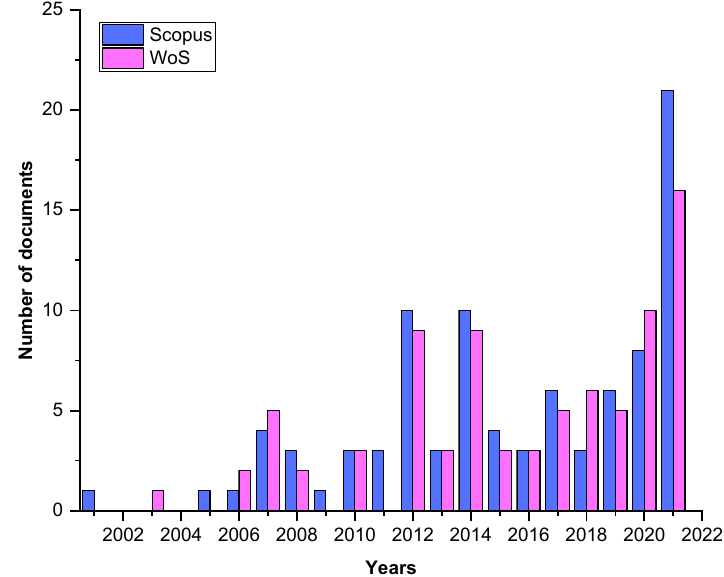
Figure 3. Publications trend of enrichment of VOs with plants antioxidants (based on data retrieved from Scopus and WoS databases).